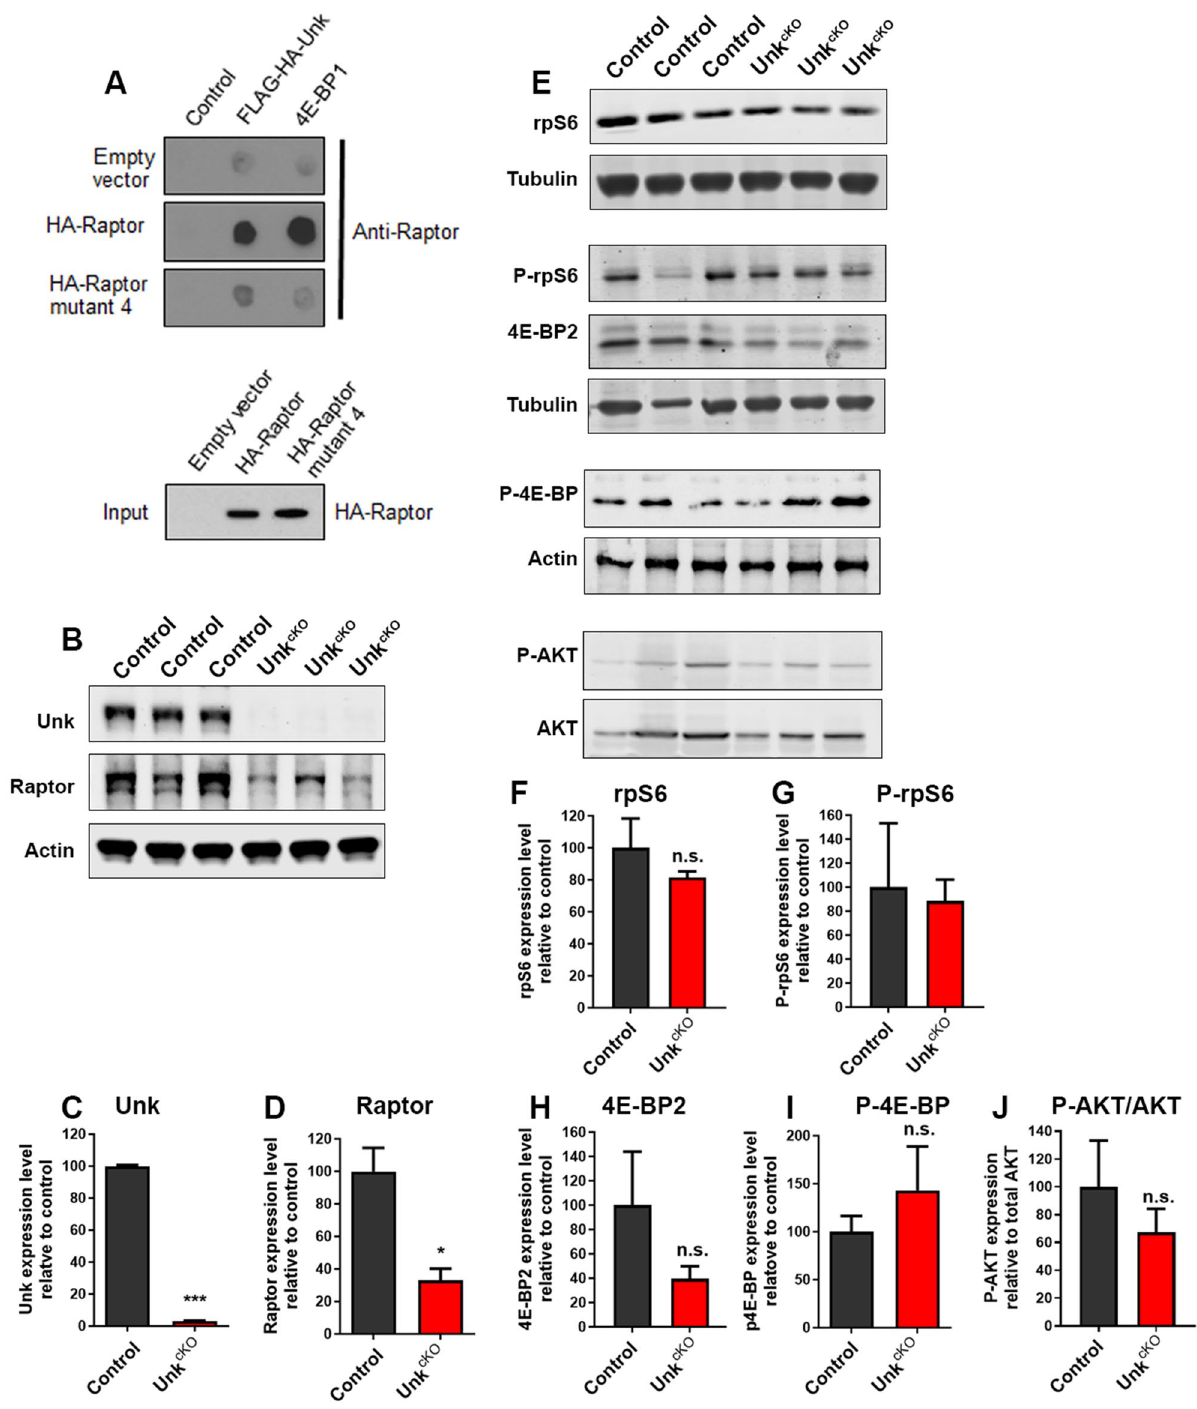
Figure 2. Unk cKO mice have reduced Raptor levels in the developing nervous system. ( A ) Unkempt binds to Raptor but not Raptor mutant 4 in a Raptor overlay assay. HA-Raptor and HA-Raptor mutant 4 expression levels were determined by western blot (lower panel). ( B ) Western blot of Raptor expression in Unk cKO E16.5 embryonic brain tissue. ( C , D ) Quantification of Unkempt and Raptor expression in Unk cKO E16.5 embryonic brain tissue. ( E ) Western blot of rpS6, phospho-rpS6 (P-rpS6), 4E-BP2 and phospho-4E-BP (P-4E-BP) expression in Unk cKO E16.5 embryonic brain tissue. ( F – J ) Quantification rpS6, P-rpS6, 4E-BP2, P-4E-BP and P-AKT expression in Unk cKO E16.5 embryonic brain tissue. Data are represented as mean ± SEM. Student’s t test, * p < 0.05, *** p < 0.001, n.s. not significant. Control n = 3, Unk cKO n = (P-rpS6) levels in the brain were similar in controls and Unk cKO embryos (Fig. 2E–G; Supplemental Figure S3C). Total 4E-BP2 and phospho 4E-BP (P-4E-BP) levels in the brain were also not significantly different between